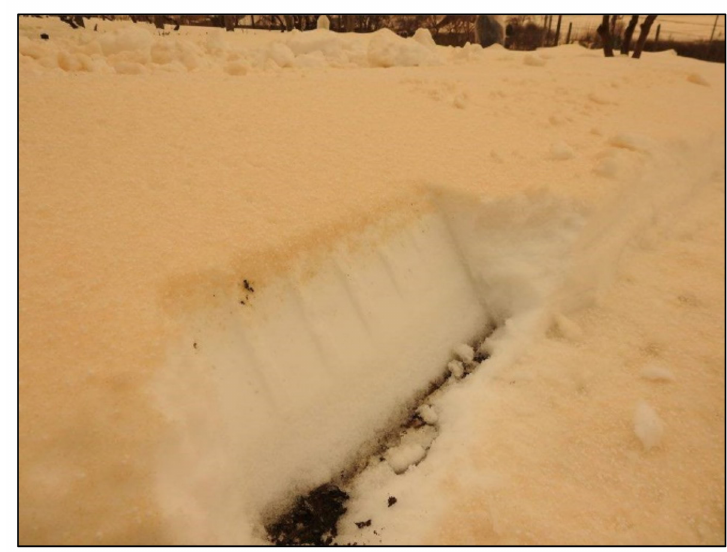
Figure 10. Saharan dust associated with snow deposit in Isaccea, southeastern Romania, on the 23 rd of March 2018. Photo: Bolboac ă ,